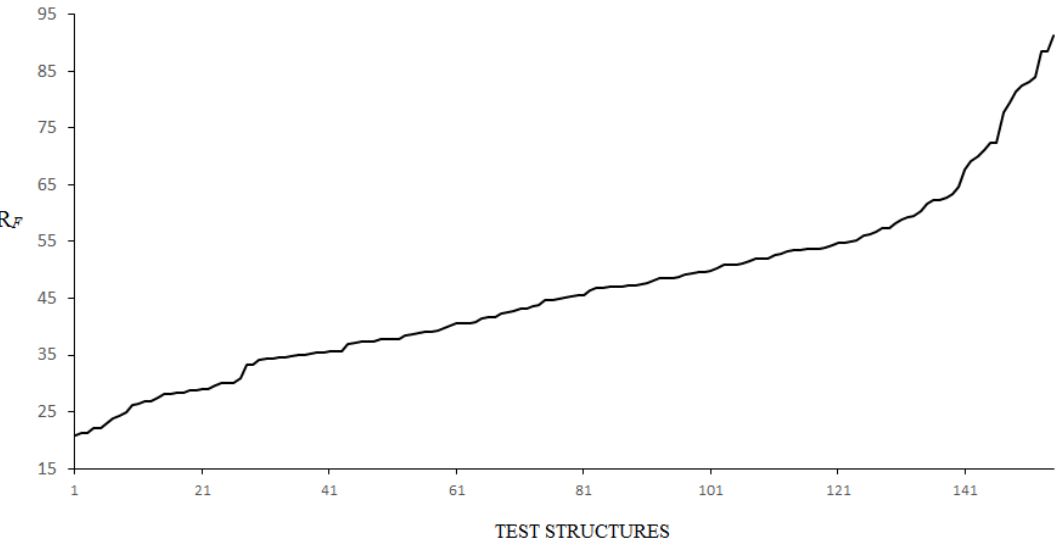
Figure 1. The R F value corresponding to each of the 155 test structures reported in Table 1. The structures have been ranked by the increasing value of R F .